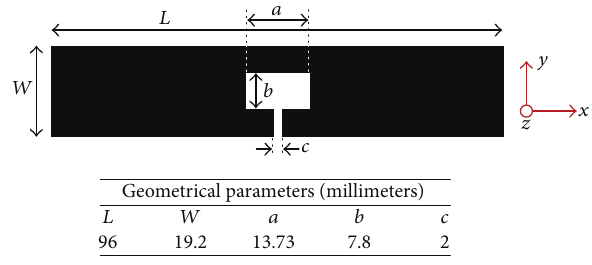
Figure 1: Antenna